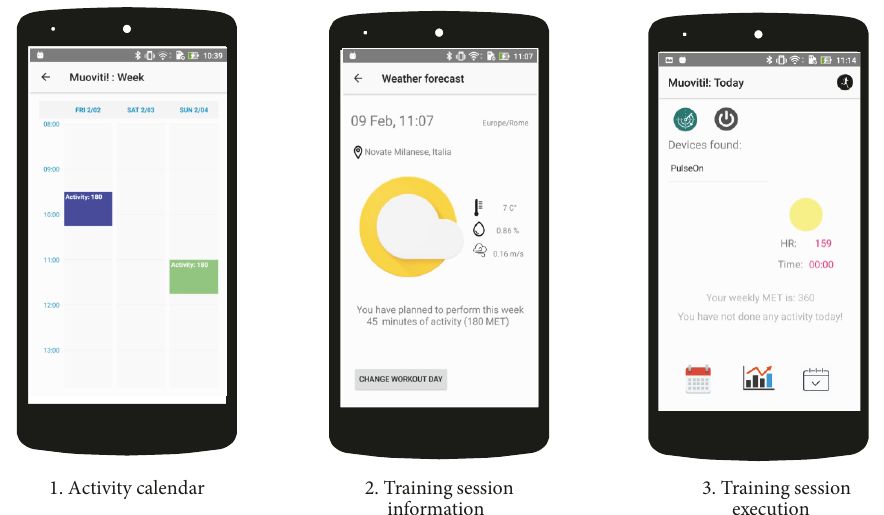
Figure 3: Screenshots from the GUI of the Muoviti!